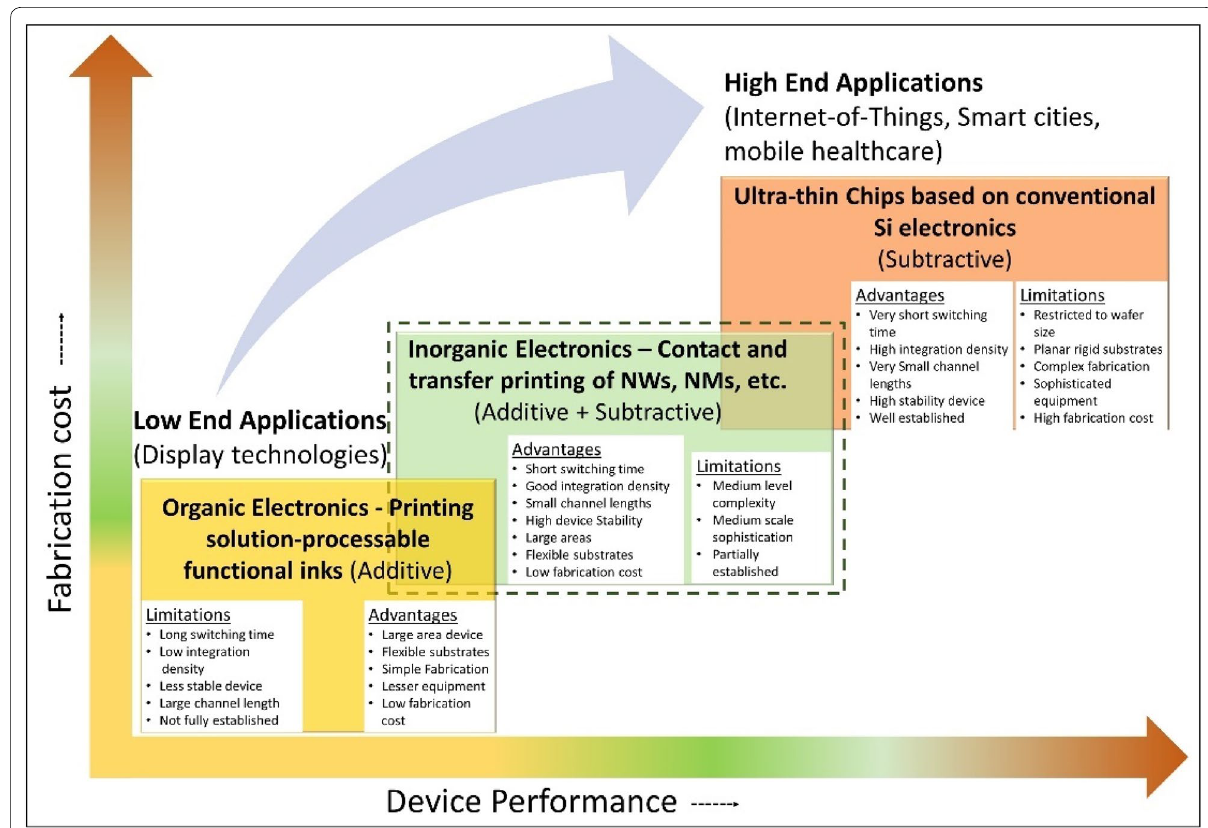
Fig. 2 Different manufacturing routes for the fabrication of large area electronics and the relation between fabrication-cost and device-performance. Inorganic printed electronics could potentially provide the long-term solution for high performance large area